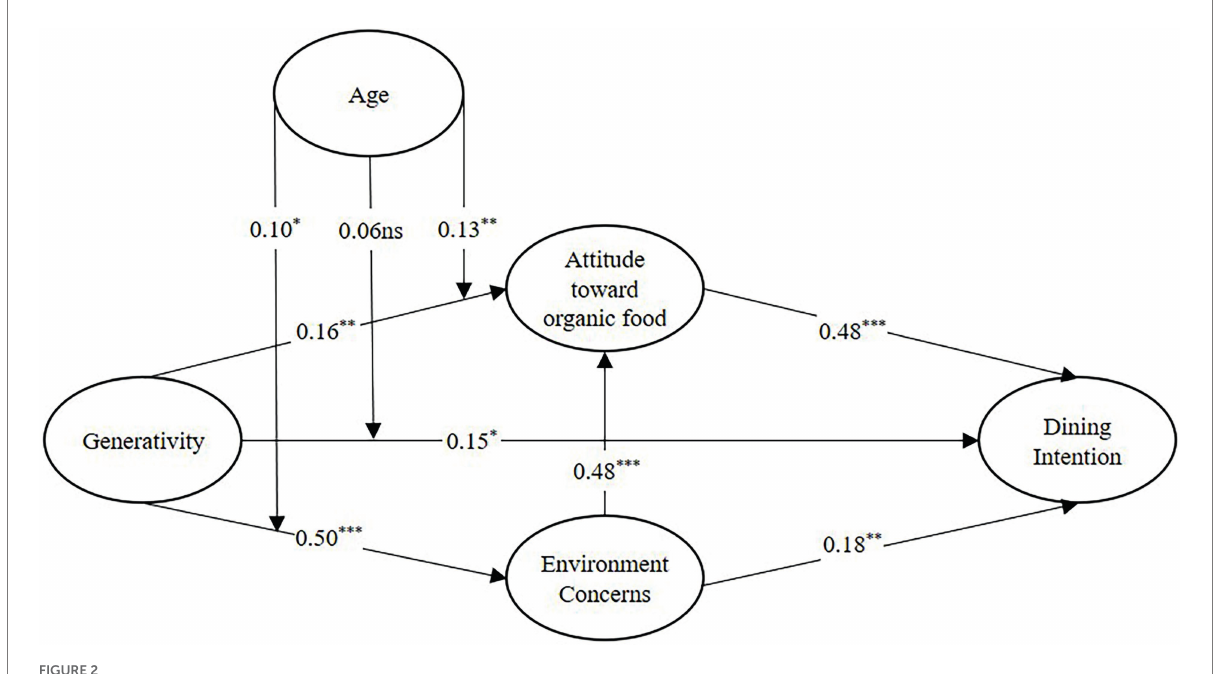
FIGURE 2 Structural model.